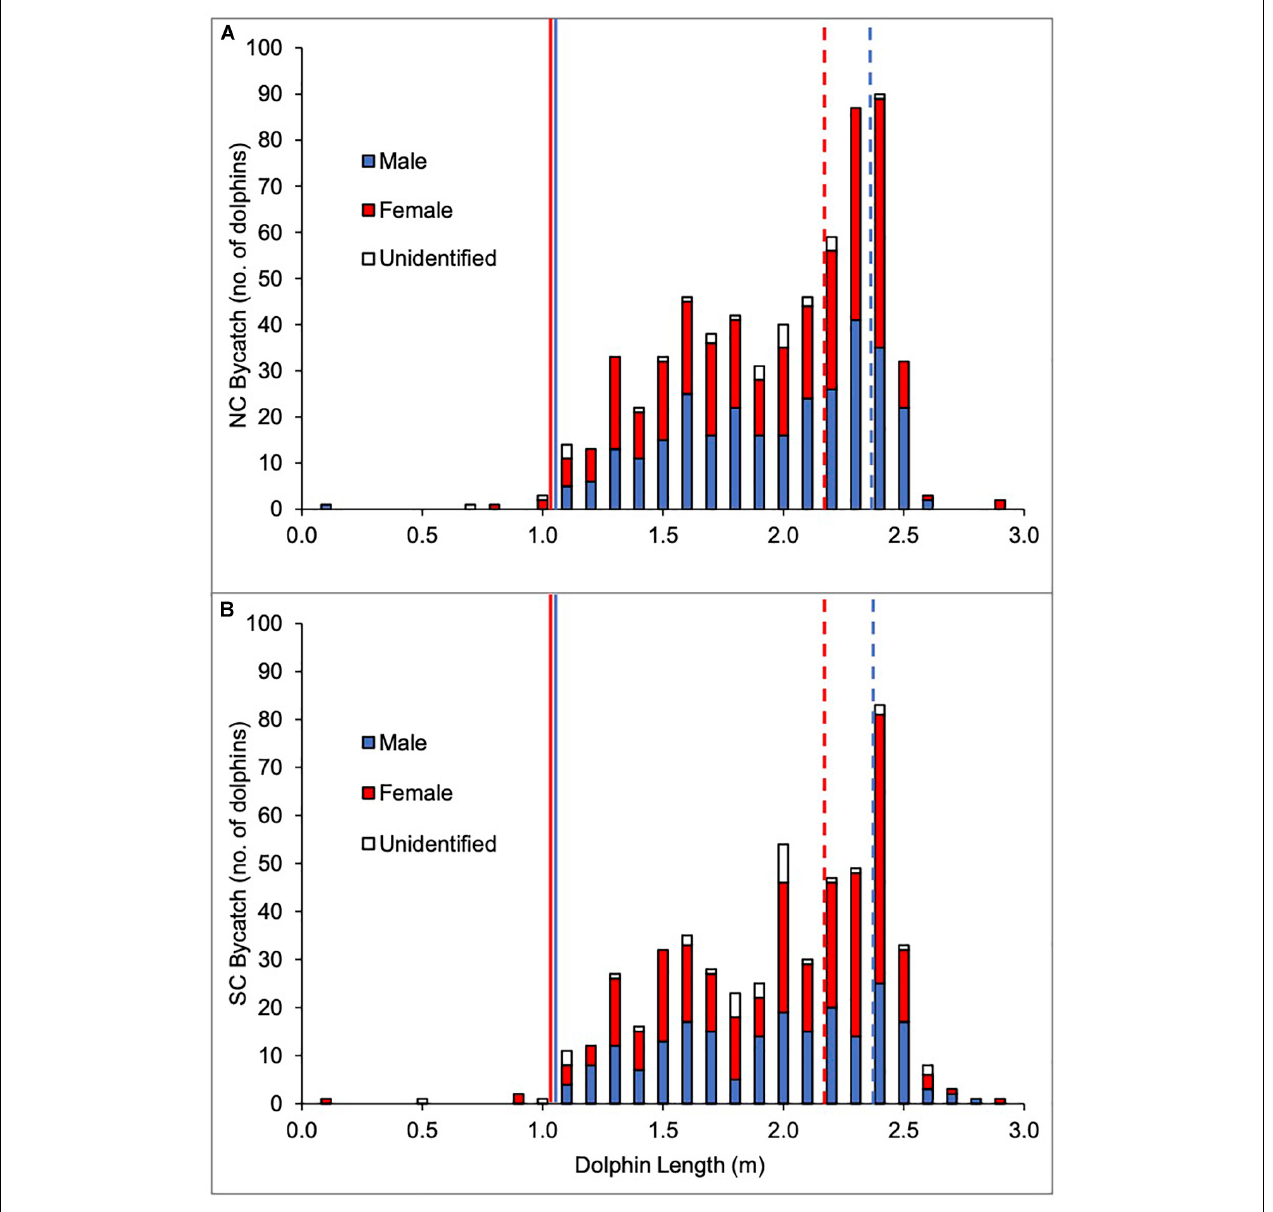
FIGURE 2 | Length distribution by sex of Indo-Pacific bottlenose dolphin ( T. aduncus ) bycatch between 1980 and 2015 for the two areas: North Coast (NC; A ) and South Coast (SC; B ). Length at sexual maturity (as used in the analysis): 2.4 m (males) and 2.2 m (females).